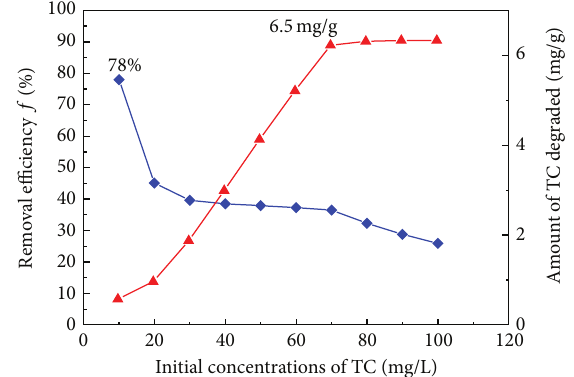
Figure 6: Removal efficiency varies with the microwave power.